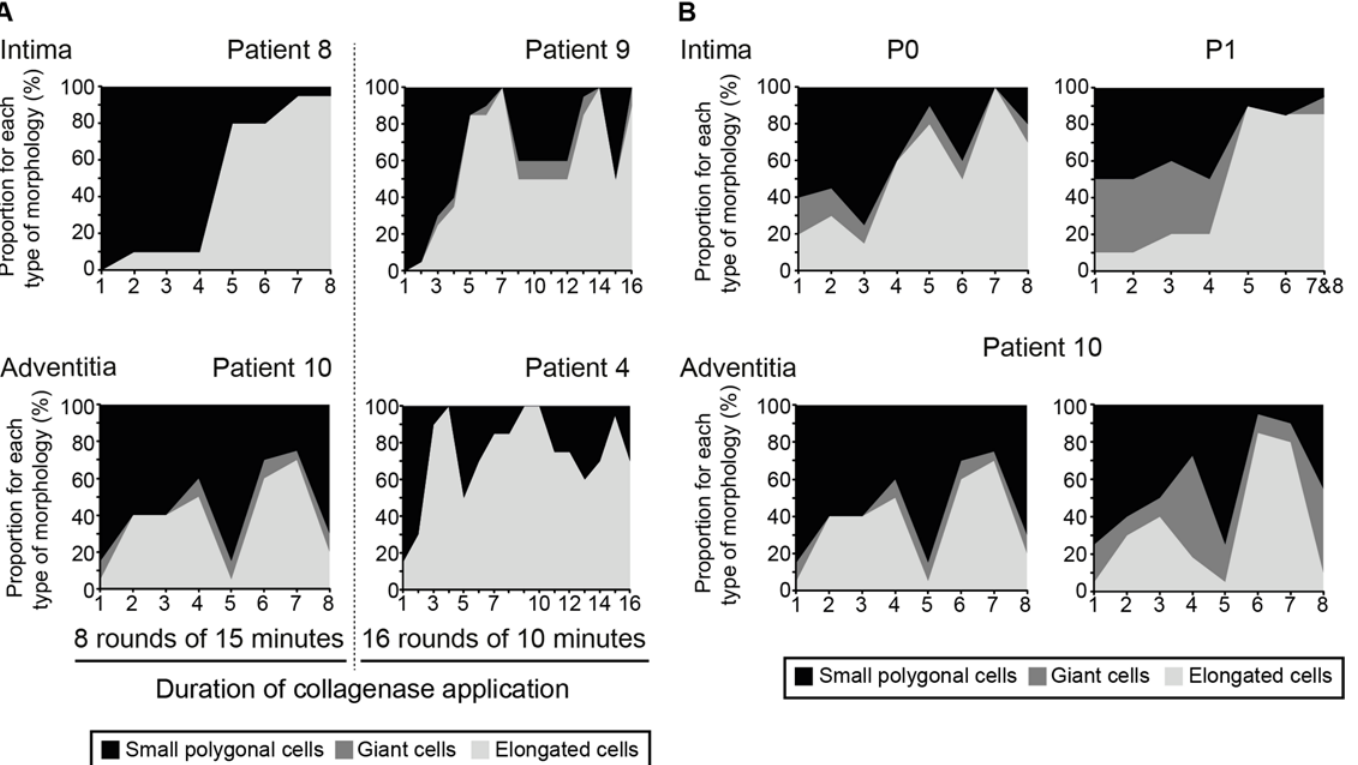
Fig 3. Optimization of the isolation procedure. ( A ) The graphs show the yield of EC-enrichment with the EC isolation procedure in optimized conditions. On the adventitial side, EC-enrichment was optimal when the collagenase was applied for 15 min and when 16 rounds of extraction were performed to obtain at least one EC-enriched fraction. On the intimal side, maximum EC-enrichment was obtained with 4 rounds of collagenase, each lasting 15 min. ( B ). Morphological analysis was also performed on P1 IECs and AECs, which could then be compared with that obtained at P0 cells to examine the effect of passaging and time in culture. The graphs show the proportion of vWf-positive cells. The general trend for the EC-contaminating cell ratio was similar for P0 and